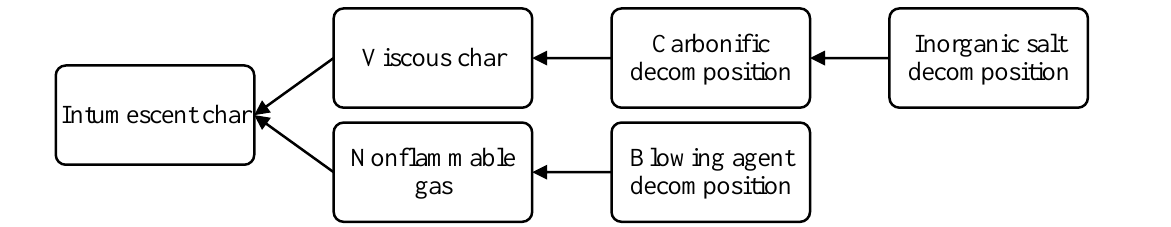
Figure 5. Schematic of intumescent reactions.